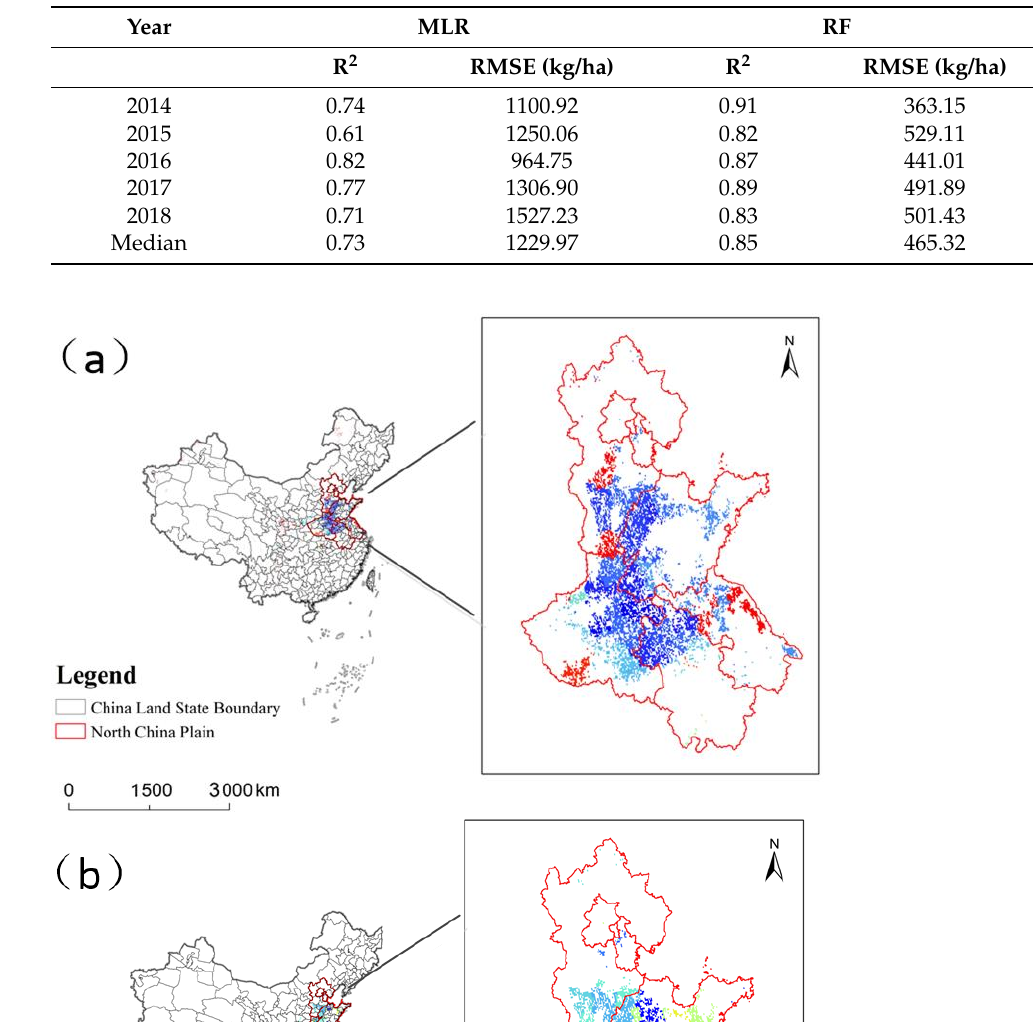
Table 2. The validation results of “leave one-year out” experiment.